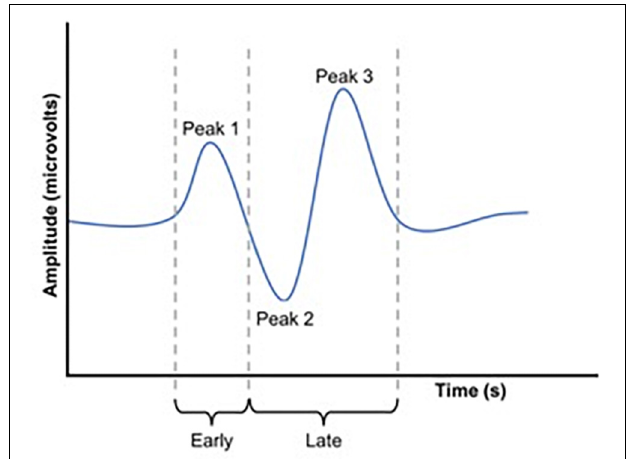
FIGURE 2 | Schematic representation of a VEP waveform. RMS values were calculated for both an early and a late window. These windows were set to capture P1 (early window) and P2 and P3 (late window).